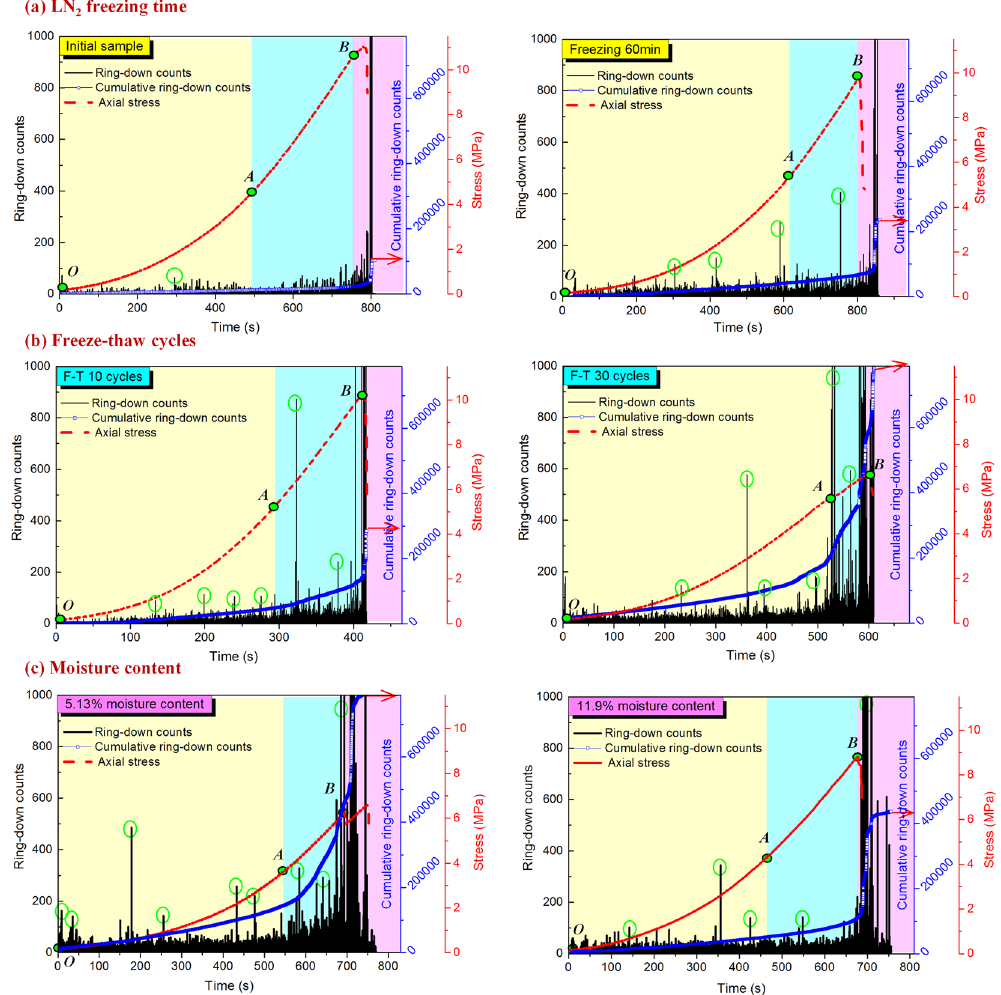
Figure 3. Acoustic emissions and uniaxial compression strengths for frozen-thawed coal. ( a ) LN 2 freezing time; ( b ) freeze-thaw cycles; ( c ) coal’ moisture